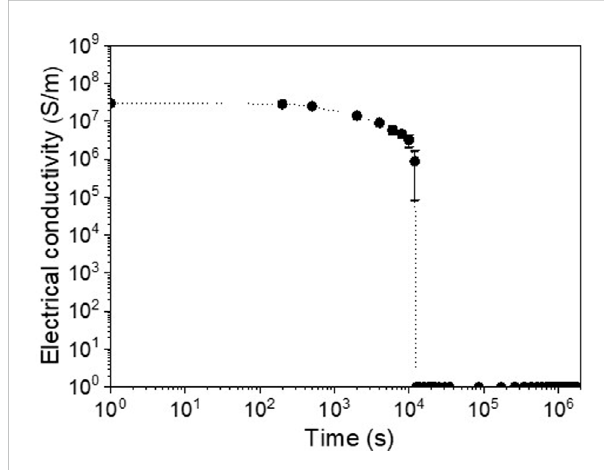
FIGURE 4 Electrical conductivity of the SCCY as a function of immersion time in a 1 M NaCl solution at 60 °